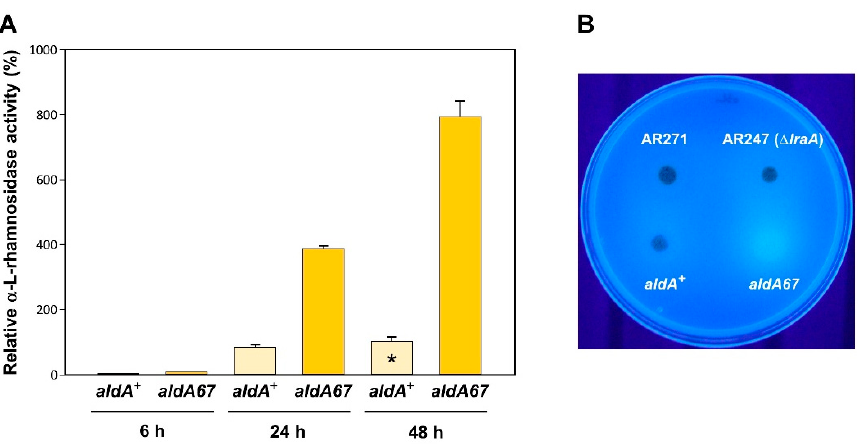
Figure 3. Enhanced extracellular α -L-rhamnosidase activity in the aldA loss-of-function mutant aldA67 : ( A ) time course of extracellular α -L-rhamnosidase activity produced by control AR462 ( yA2 , pabaA1 ) and mutant AR463 ( aldA67 , pabaA1 , yA2 ) mycelia in liquid culture after transfer to inducing conditions (1% L-rhamnose) assayed using the artificial substrate 4-nitrophenol α -L- rhamnopyranoside ( p NPR). Activity (means + standard deviation) is expressed as a percentage relative to that of the control strain at 48 h * (100%). Measurements were made in duplicate on three biological replicates. ( B ) qualitative assessment of extracellular α -L-rhamnosidase activity on non-inducing solid medium (1% lactose) as revealed by hydrolysis of 4-methylumbelliferyl α -L-rhamnopyranoside (MUR); 2 µ L drops of conidial suspensions at a titre of 10 7 conidia/mL were